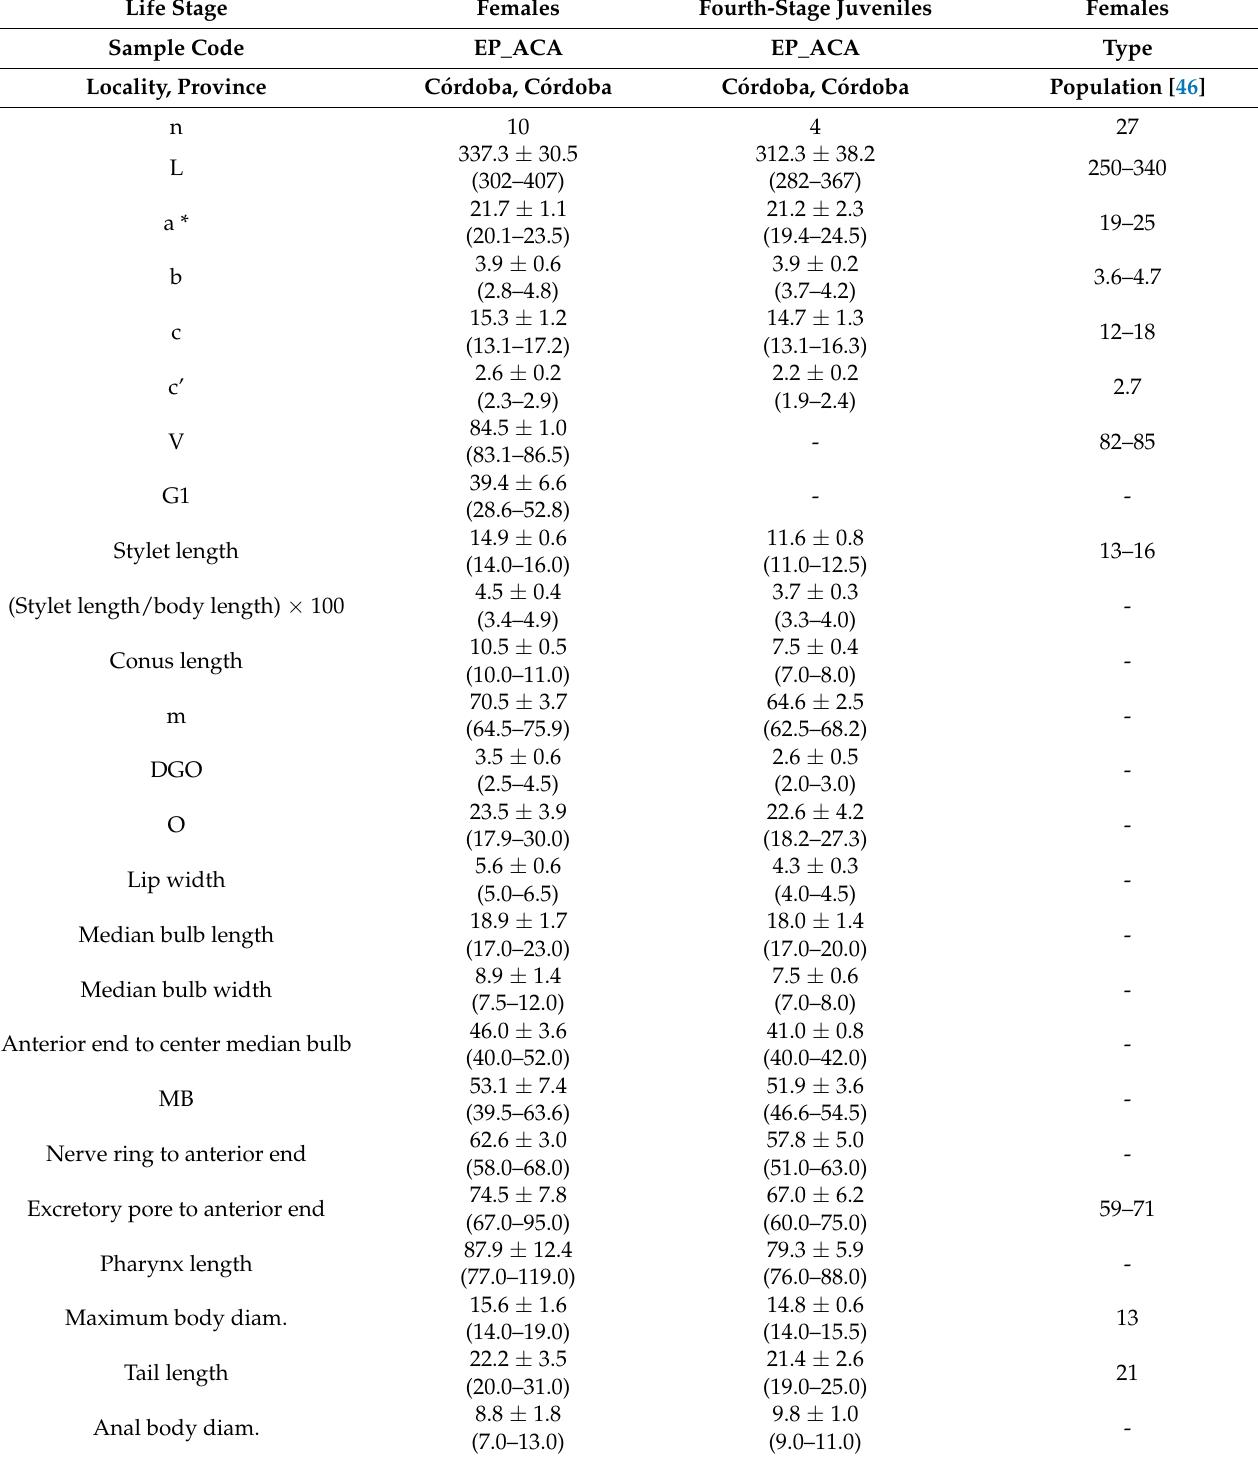
Table 11. Morphometrics of Paratylenchus variabilis Raski, 1975 from C ó rdoba, C ó rdoba, Spain. All measurements are in µ m and in the form: mean ± s.d.